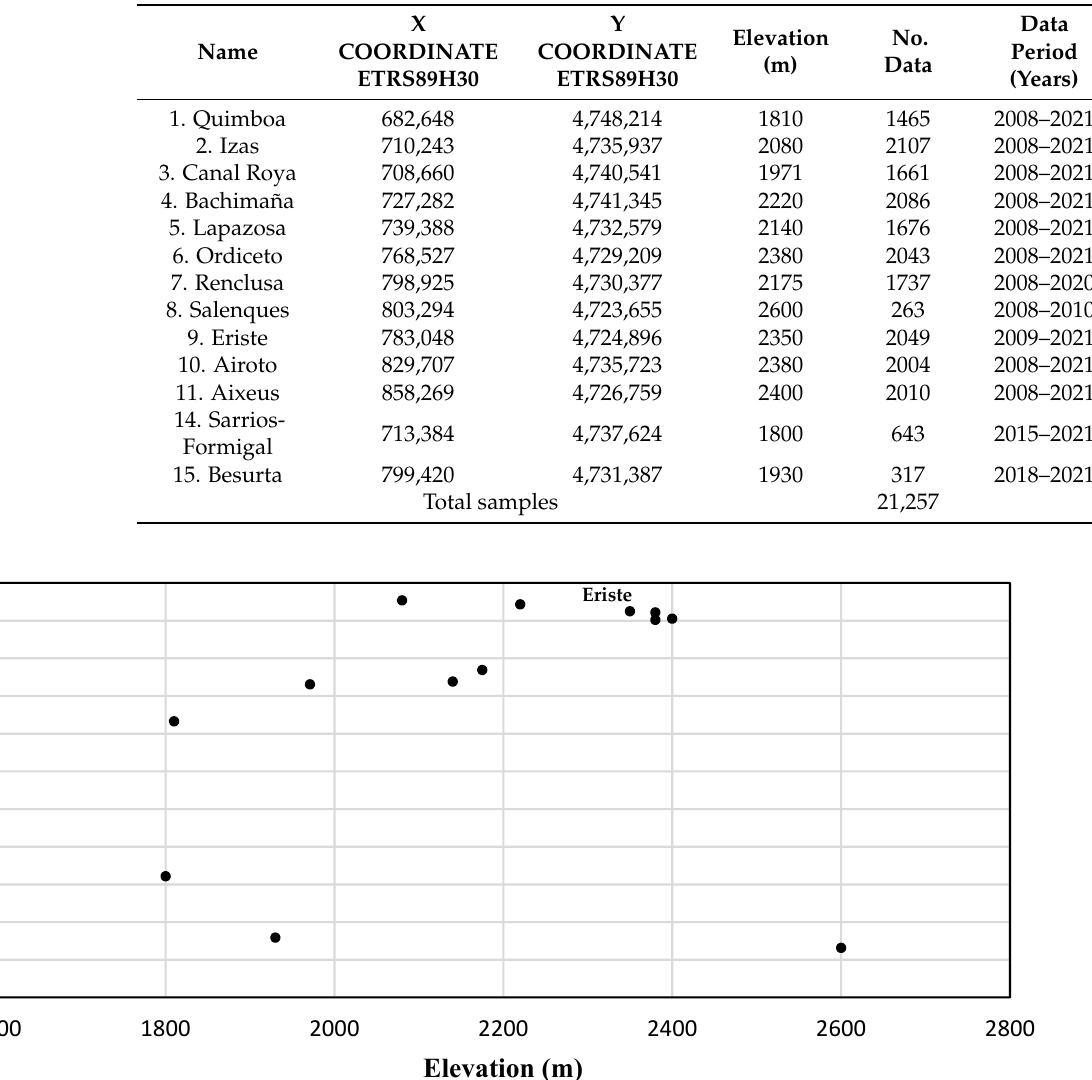
Table 2. On-site non-destructive measurements. TNM sites.